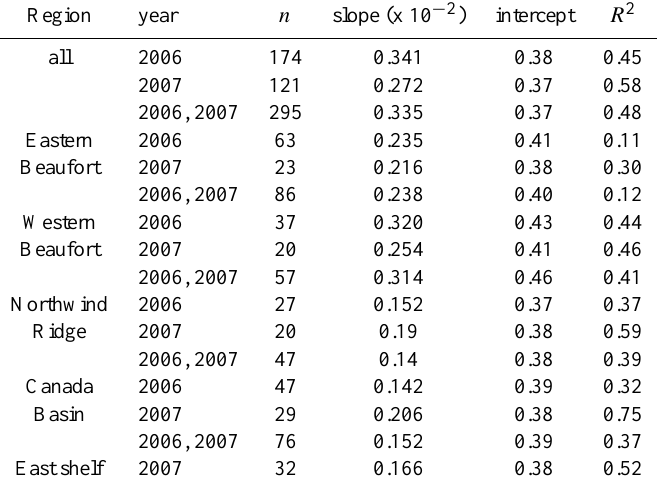
Table 2. A comparison of the relationships between beam attenuation coefficient and particulate organic carbon. The symbol n represents the number of samples in each linear regression. The units for slope and intercept are m − 1 (µgCkg − 1 ) − 1 and m − 1 ,